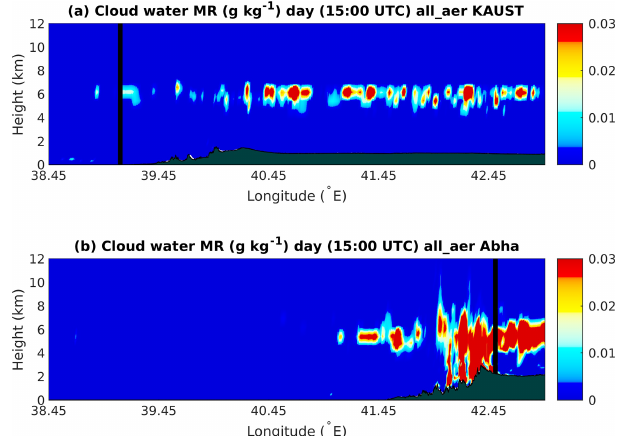
Figure 10. Profile of cloud water mixing ratio for a longitudinal section passing through (a) KAUST and (b) Abha, averaged for 4– 31 August 2015 at 15:00UTC. The location of KAUST and Abha city are indicated with black vertical